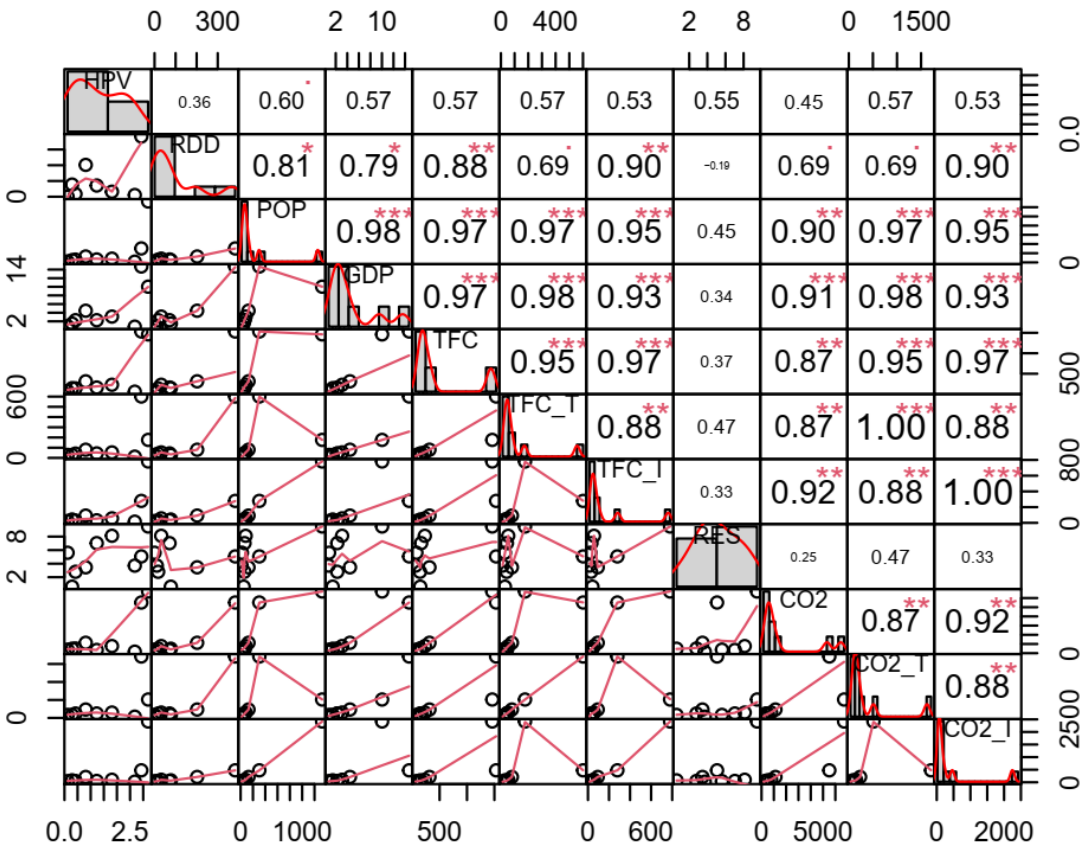
Figure 2. Spearman’s correlation and compilation of data for all analyzed countries in 2008. *, **, ***—the more symbols, the stronger the correlation. Abbreviations: HPV—hydrogen production volume; RDD—energy RD&D in the hydrogen production and fuel cells category; POP—population; GPD—gross domestic product; TFC—total final energy consumption; TFC_T—total final energy consumption in transport; TFC_I—total final energy consumption in industry; RES—share of renewable energy of primary energy supply; CO2—total carbon dioxide emissions; CO2_T—total carbon dioxide emissions in transport; CO2_I—total carbon dioxide emissions in